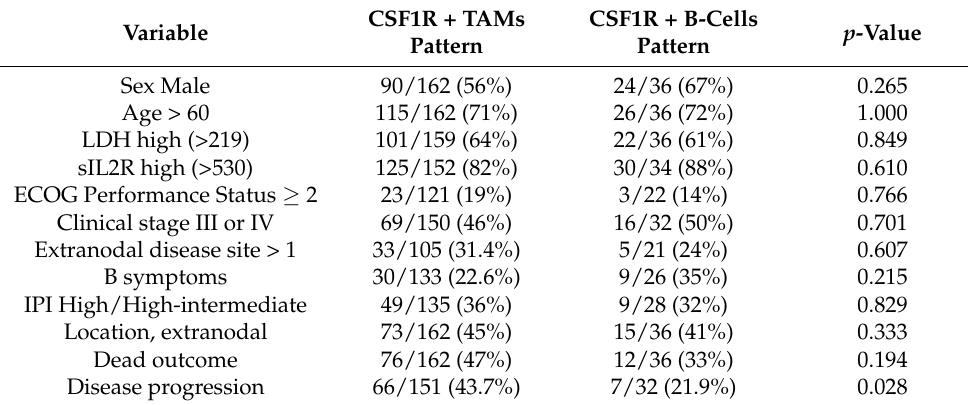
Table 3. Correlation between the histological patterns of CSF1R and the clinical characteristics of the patients (Tokai series).